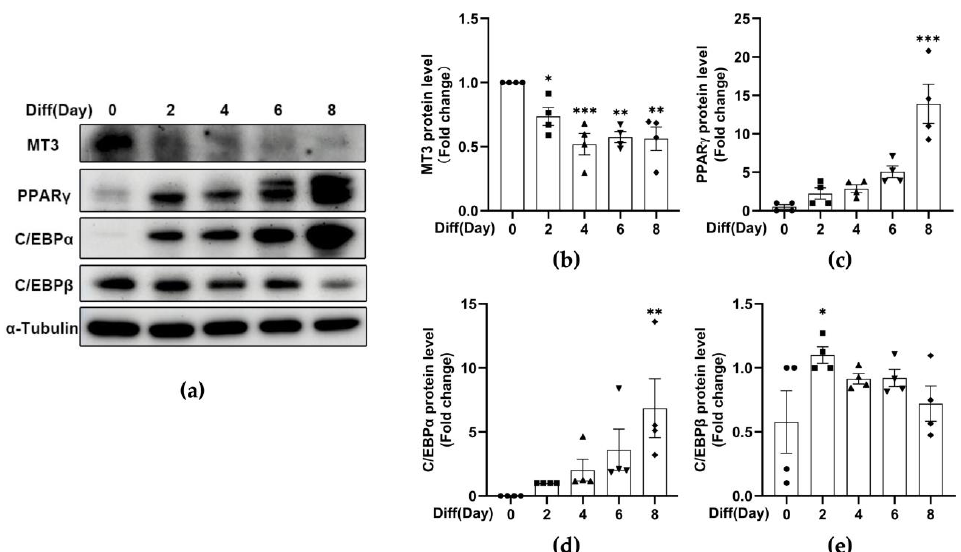
Figure 2. The protein levels of MT3 are significantly decreased during 3T3-L1 adipocyte differentiation. The differentiation of 3T3-L1 adipocytes was induced by the differentiation cocktail. ( a ) Immunoblotting was used to detect the protein levels of MT3, C/EBP α , C/EBP β , PPAR γ , and α -Tubulin at specified times (days 0, 2, 4, 6, and 8). α -Tubulin was used as a loading control. ( b – e ) The intensities of bands (MT3, C/EBP α , C/EBP β , and PPAR γ ) were quantified and normalized with the corresponding α - Tubulin bands. The data are presented as the means ± SEM. * p < 0.05, ** p < 0.01, *** p < 0.001 vs. the corresponding control group (day 0) were calculated by one-way ANOVA followed by Dunnett’s